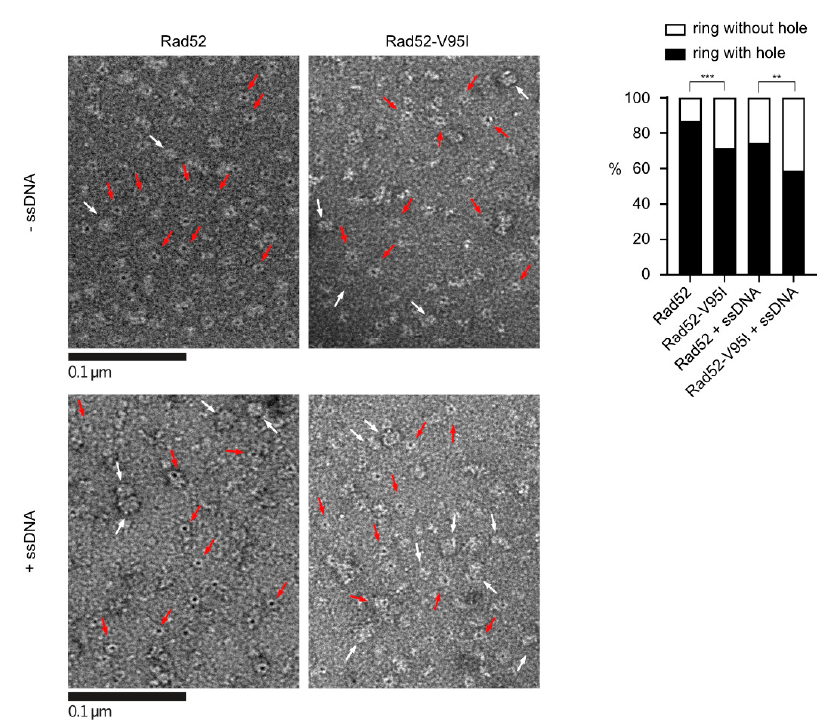
Figure 5. EM analysis of Rad52 and Rad52-V95I without DNA (upper panels) or with 400nt-ssDNA (lower panels). All experiments were performed with FLAG-tagged Rad52 proteins. The protein-ssDNA complex was formed at a ratio of 1:20 nucleotides. Some representative rings with hole (red arrows) and without hole (white arrows) are shown. The percentage of each molecular species is plotted on the histogram (right panel). 641 molecules were analyzed; *** p < 0.001; ** p < 0.05 (two-tailed Fisher’s exact test).